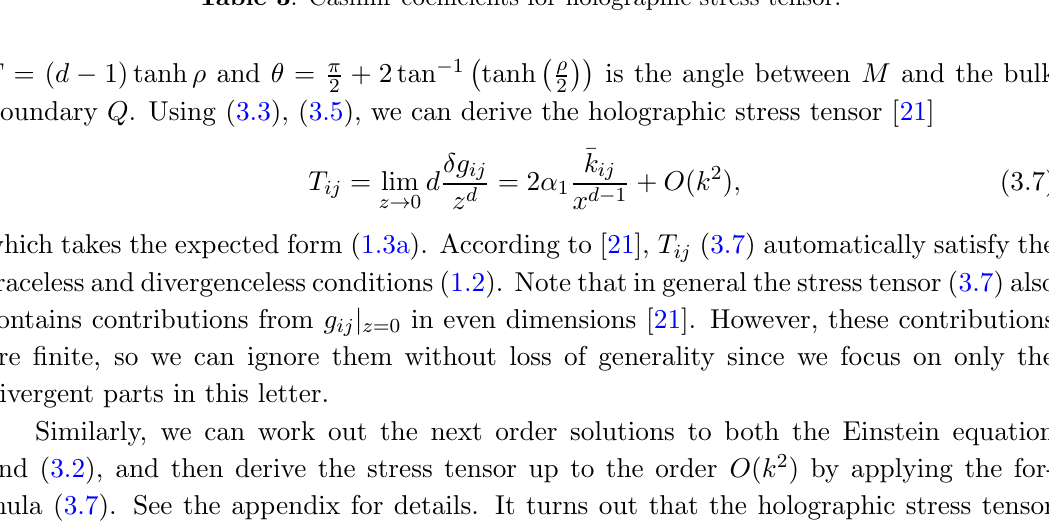
Table 3 . Casimir coe(cid:14)cients for holographic stress